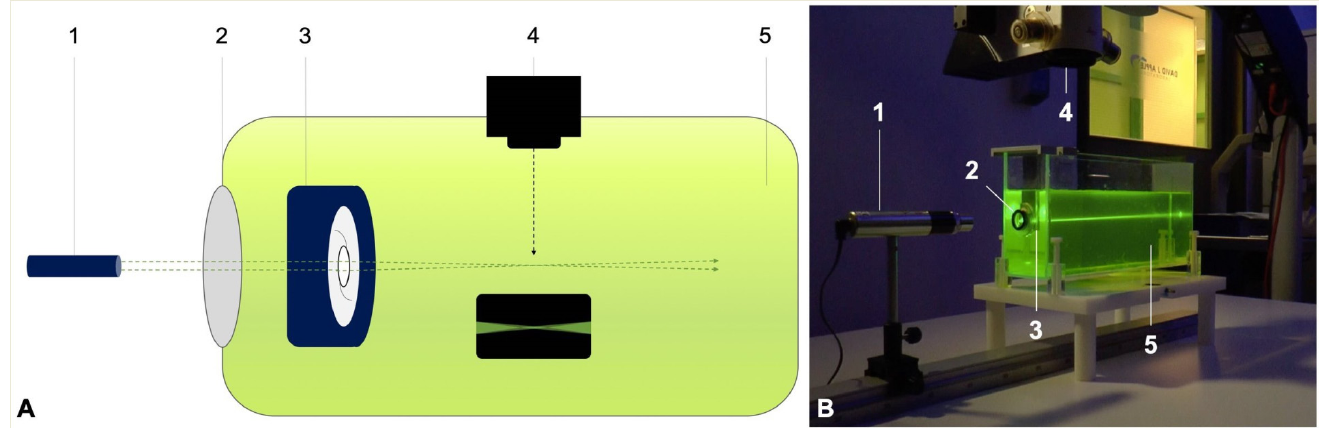
Figure 1. Experimental set-up for direct visualization of the light scattering effects. ( A ) Schematic illustration, ( B ) in vitro optical bench set-up. To elaborate, 1 = monochromatic green laser light source (532 nm); 2 = model cornea; 3 = intraocular lens holder; 4 = surgical microscope with an integrated digital camera; and 5 = water bath containing 0.01% fluorescein solution.